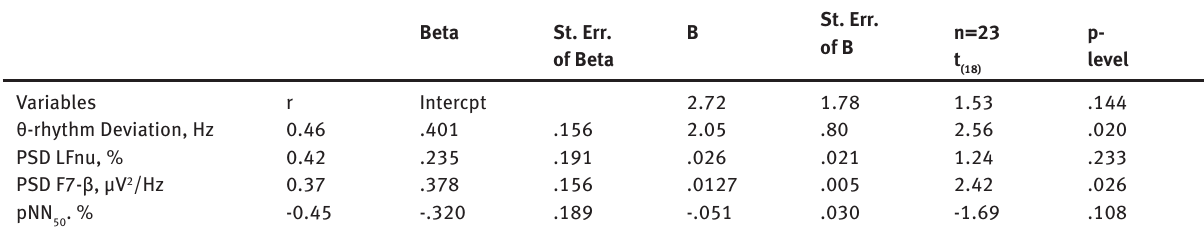
Table 3: Regression Summary for Dependent Variable: